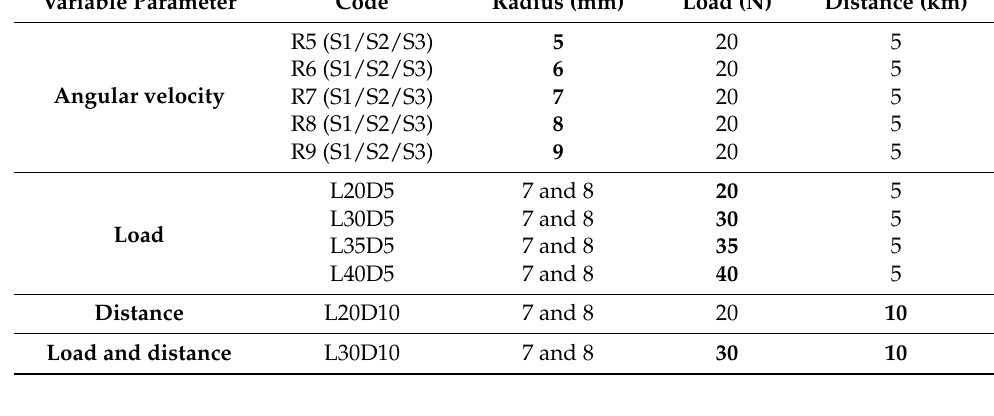
interest was systematically varied compared to the reference run mentioned above. The